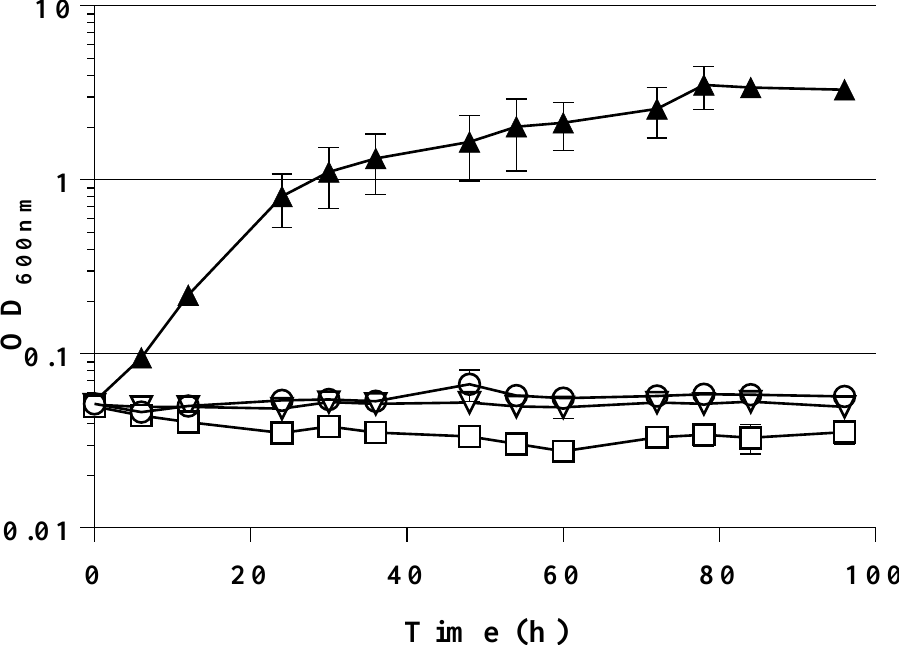
Figure3. GrowthbehaviorofGL3( ), GL3 / pJF119EH( (cid:53) ), GL3 / pJF119 fsaA ( (cid:3) ), andGL3 / pJF119 fsaA A129S (cid:35) ( (cid:78) ). Shakeflaskcultures(37 ◦ C)onMMwithglucoseassoleCsource(100 µ MIPTG,ampicillin100 µ g / mL Figure 3. Growth behavior of GL3 ( ○ ), GL3/pJF119EH ( ▽ ), GL3/pJF119 fsaA (□), and if appropriate). Note that data for GL3 are taken from Figure 2 for comparison. Mean values from GL3/pJF119 fsaA A129S ( ▲ ). Shake flask cultures (37 °C) on MM with glucose as sole C source (100 µM